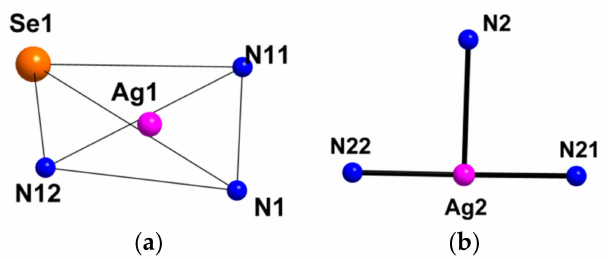
Figure 16. Coordination polyhedral of Ag1 ( a ) and Ag2 ( b ) atoms in the structure of compound 5